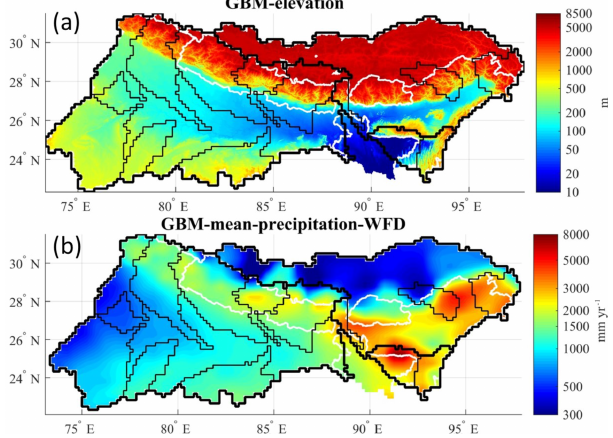
Figure 3. The (a) elevation and (b) precipitation distributions of the GBM basin.